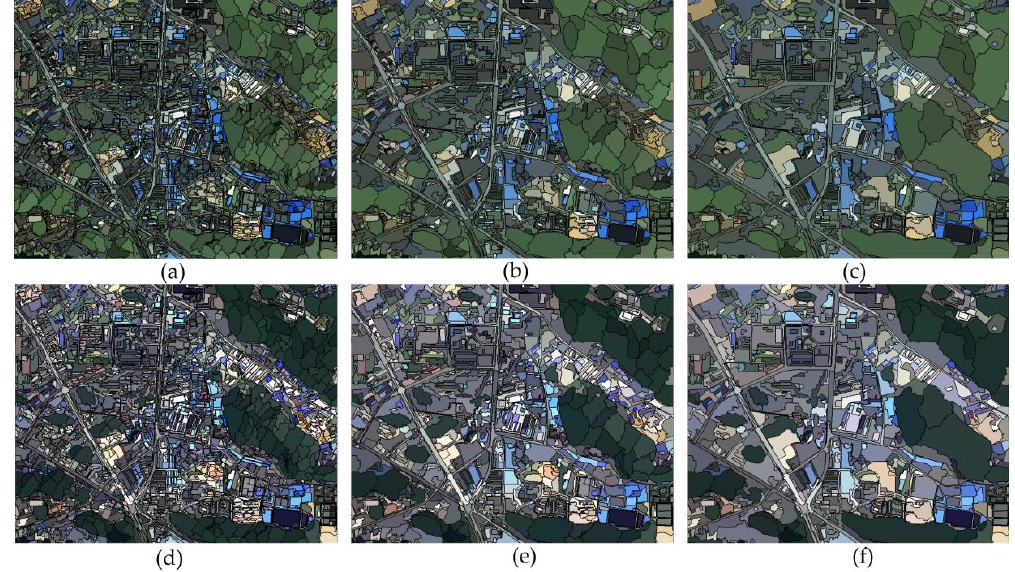
Figure 10. Mean object value maps for DS1 at various optimal scales. ( a – c ) Scales of 102, 179, and 213 for the image acquired on 13 April 2015; ( d – f ) scales of 102, 179, and 213 for the image acquired on 11 May 2016.